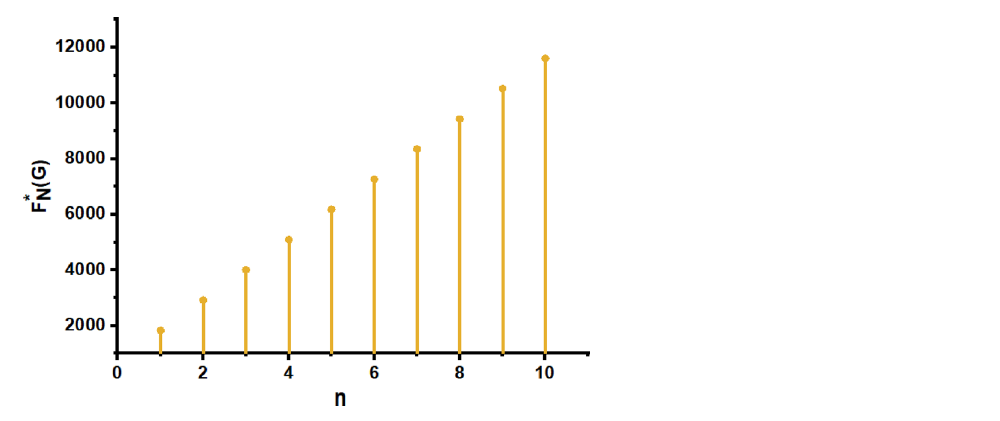
Figure 9. The comparison of n and F ∗ N ( G )